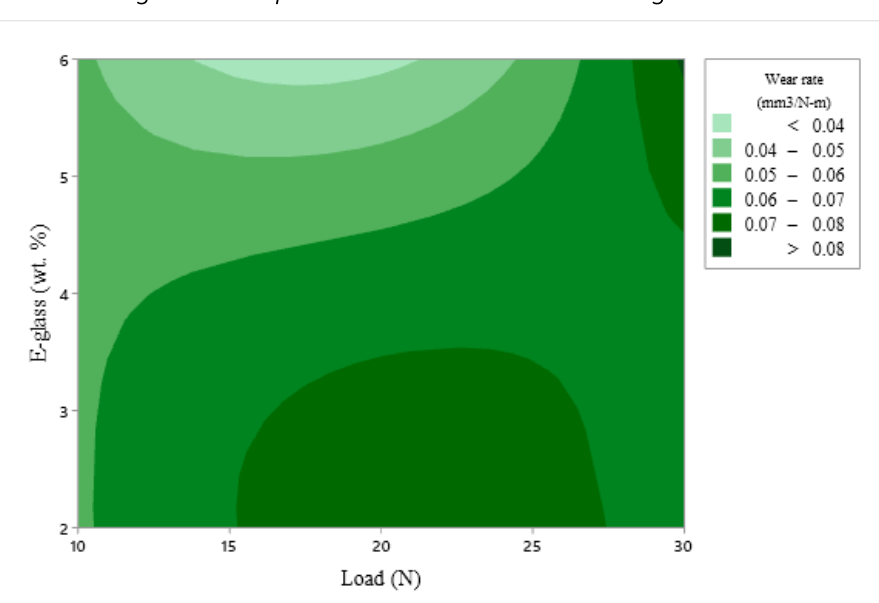
Fig. 8. Contour plot for wear rate vs. E-glass (wt. %) and load